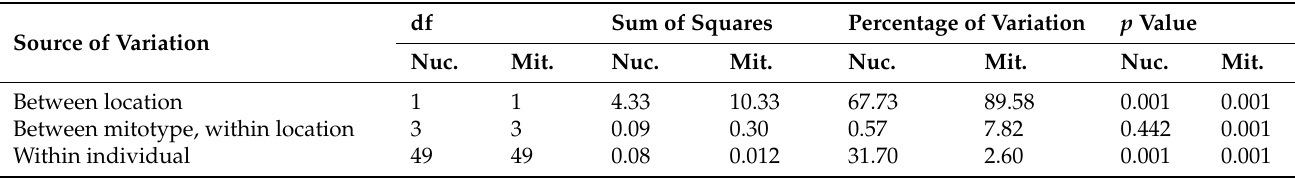
Table 1. Coefficients of the Analysis of Molecular Variance (AMOVA) of nuclear (Nuc) and mitochon- drial (Mit) SNPs considering three strata (location, mitotype, and individual).